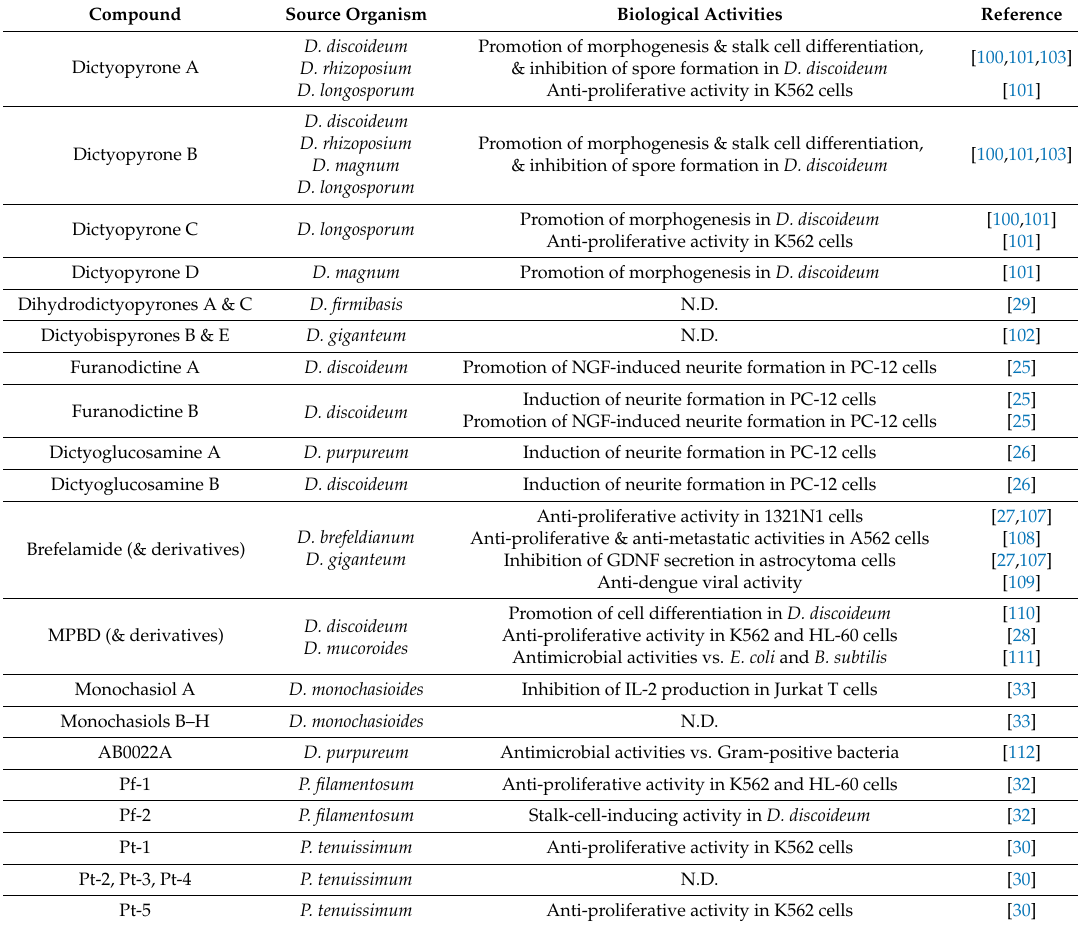
Table 2. Origins and biological activities of the compounds that were found in cellular slime